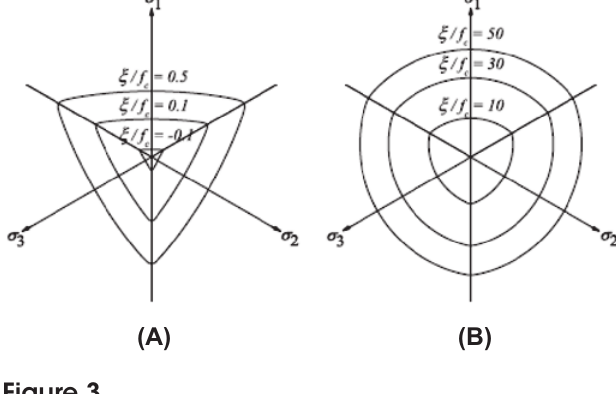
Representation of the Ottosen yield criterion in the deviatory planes using the Haigh-Westergaard stress space, for (a) low and (b) high hydrostatic stress. (PEREIRA et al. [8])